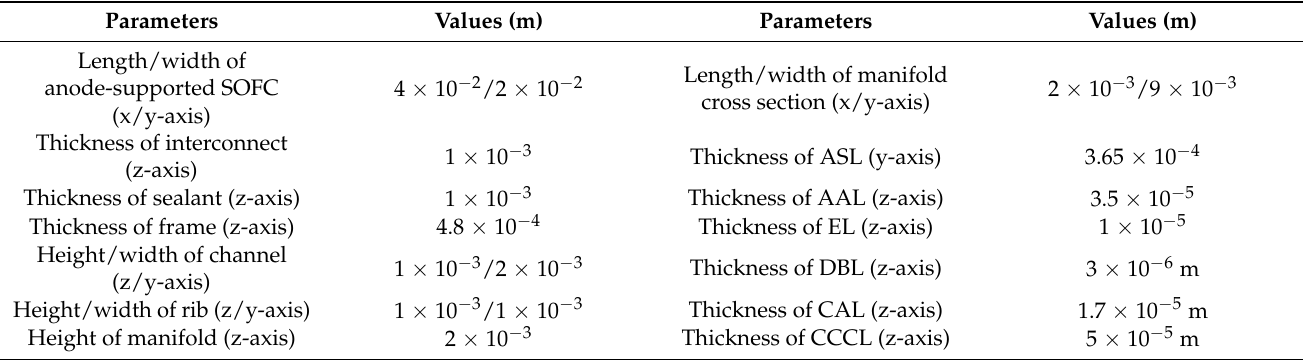
Figure 2. The schematic illustration for: ( a ) the computational domain; ( b ) the channel units. Table 2. Geometrical parameters of simulation domain.